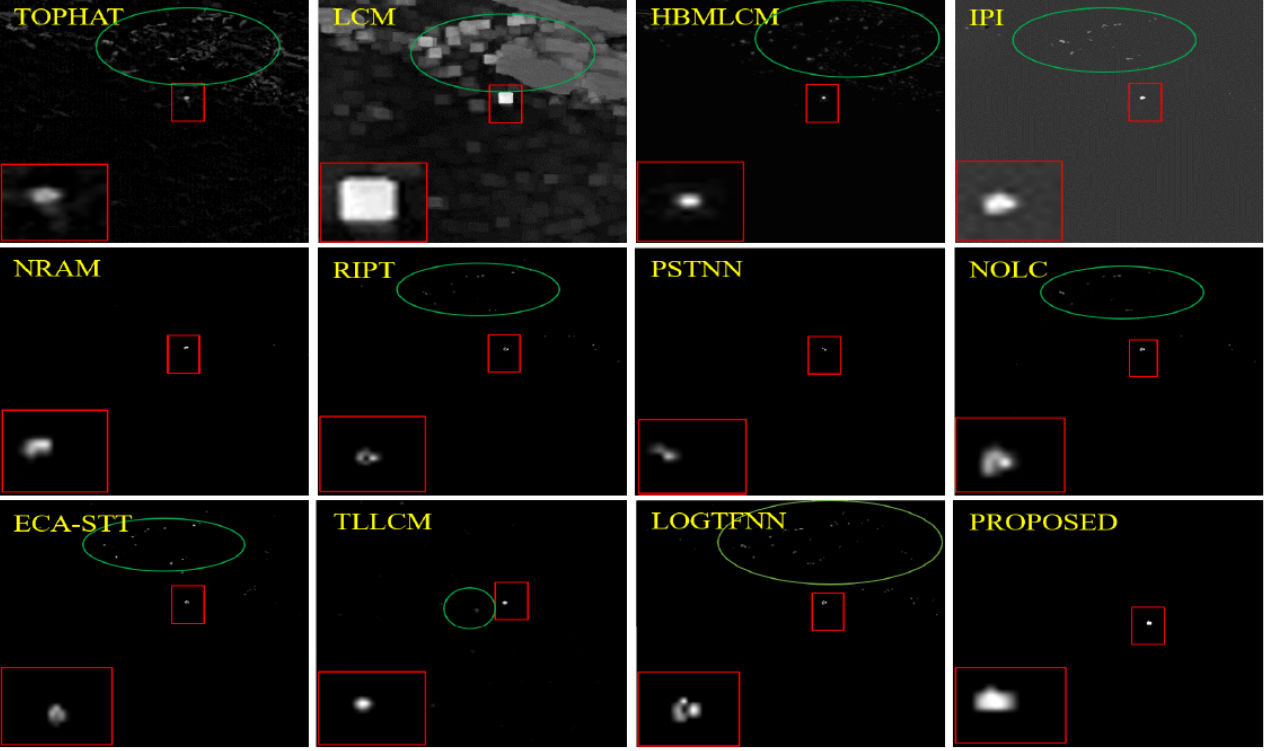
Figure 23. The detection results of data